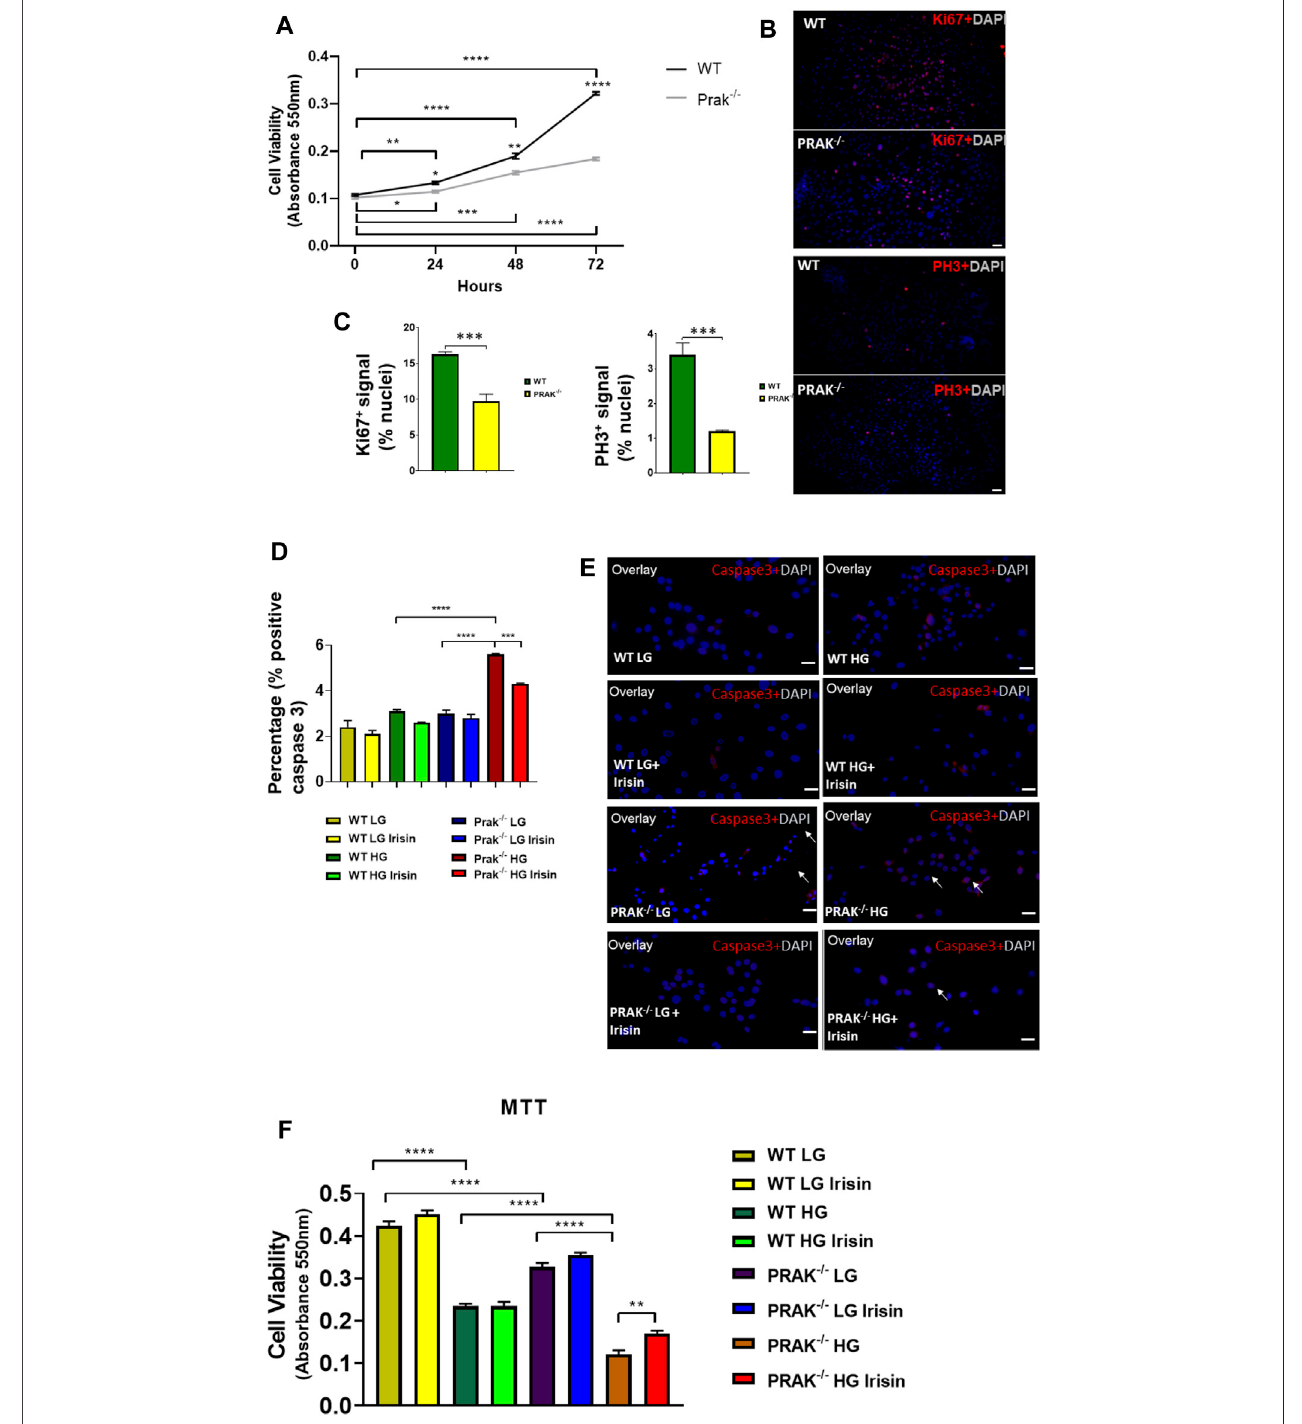
FIGURE 2 | Knockout of PRAK suppresses cell growth and increased apoptosis of cells to high glucose damages: (A) : Knockout of PRAK delayed cell growth as estimated by 3-(4,5-dimethylthiazol-2-yl)-2,5-diphenyltetrazolium bromide (MTT) assay ( n (cid:2) 5/each group); * p < 0.05; ** p < 0.01; *** p < 0.001, **** p < 0.0001. (B) : Immunochemical stainingofKi67 and phosphorylatedhistone 3inboth WT and PRAK − / − C2C12 cells; (C) :Quanti fi cation ofKi67 and phosphorylatedhistone 3-positive nuclei in wild type and PRAK − / − C2C12 cells. (D) : Quanti fi cation of active caspase-3-positive nuclei among wild type and PRAK − / − C2C12 cells in response to low glucose and high glucose with/without irisin treatment. Values represent means ± SE ( n (cid:2) 5/each group), there were approximately 50 – 100 cells were randomly accounted in each group; *** p < 0.001; **** p < 0.0001; active-caspase 3 was signi fi cantly reduced by irisin treatment. Irisin mitigated the increase in active caspase 3